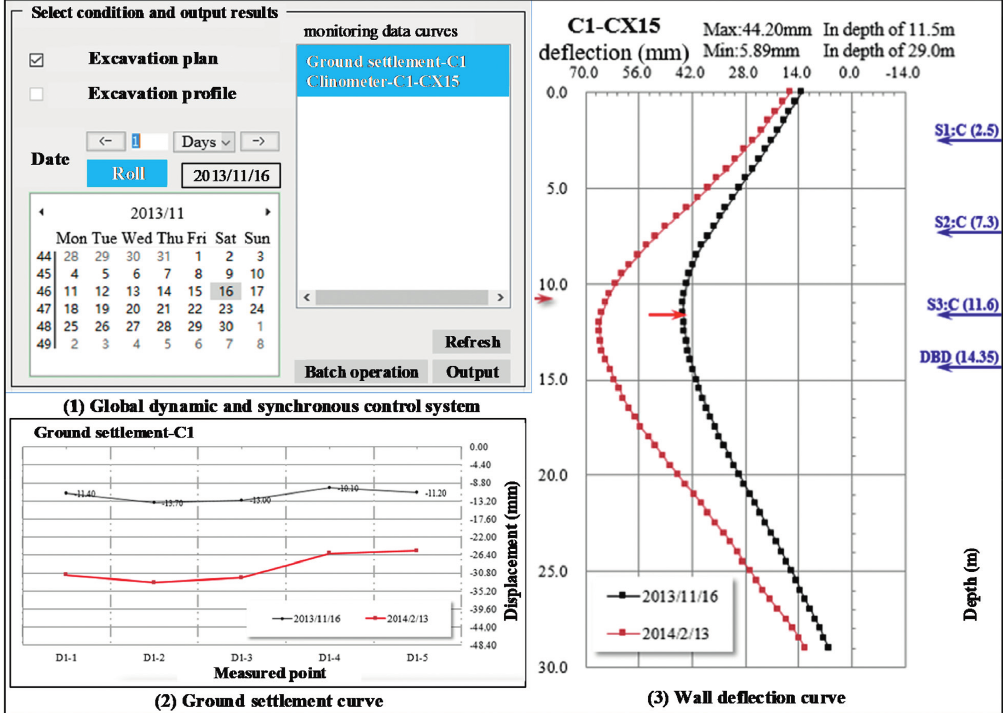
Figure 5: Dynamic and coupled analysis of monitoring with excavation